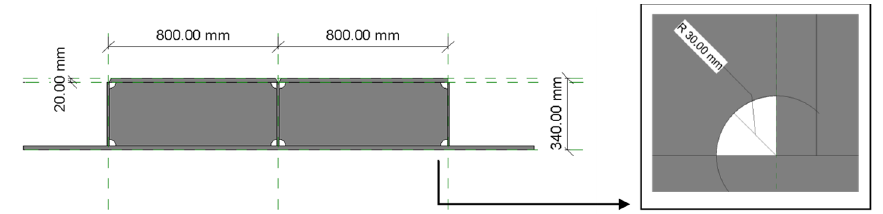
Figure 17. Detail of the internal holes at the corners with a radius of 30 mm.